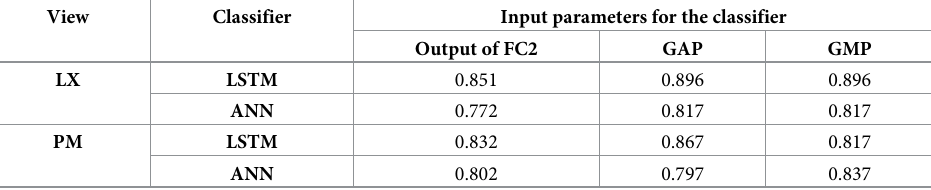
Table 6. Overall classification accuracy with changing parameters.